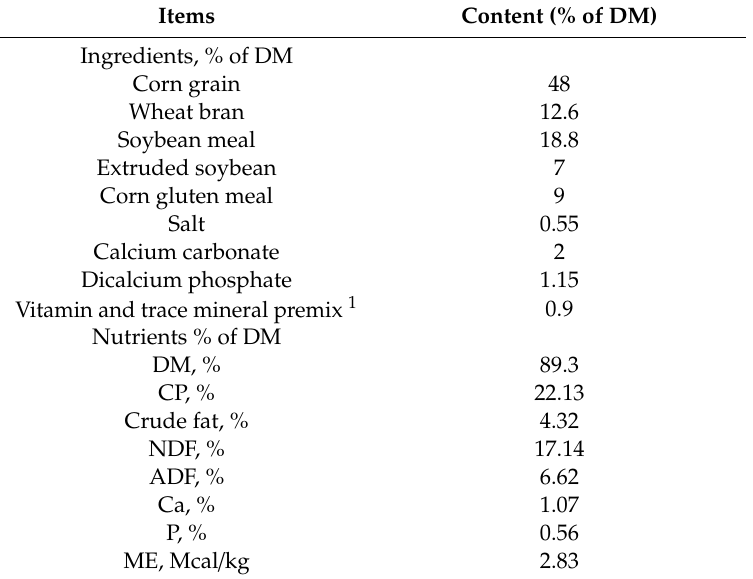
Table 1. Ingredient and nutrient composition of the experimental calves’ starter.